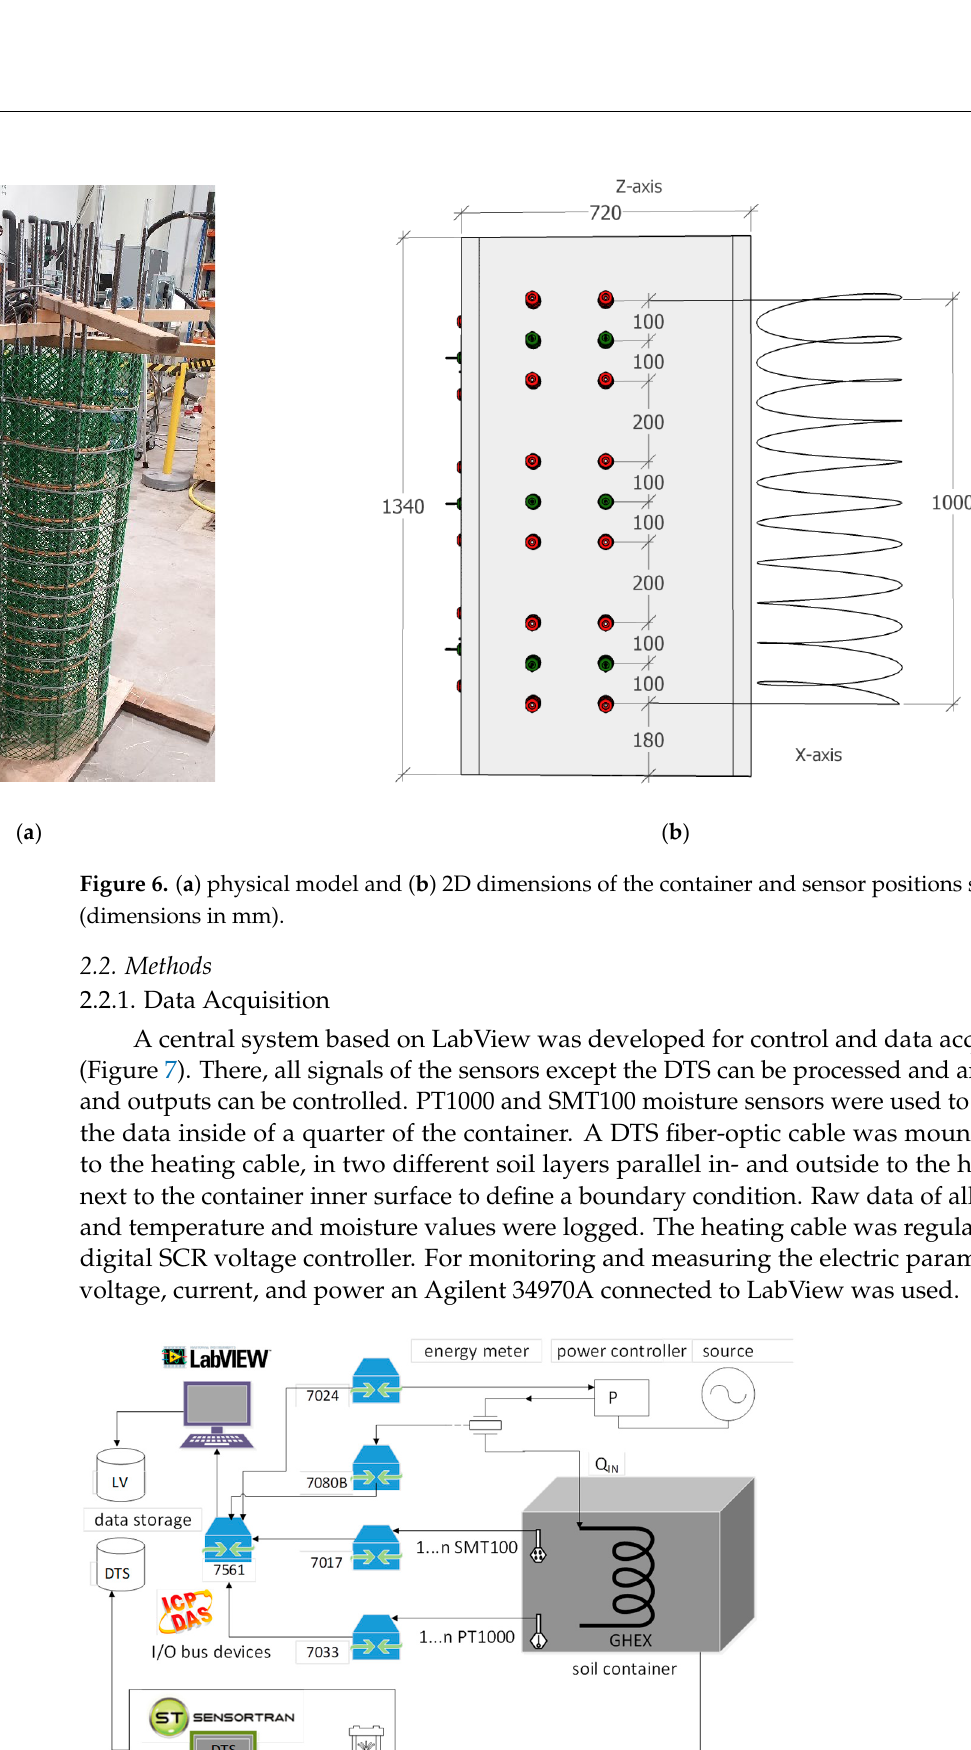
Figure 8. Coordinate system in container — isometric top view. Figure 9 shows the data points of the DTS system based on the three different diameters. “Basket” refers to the respective support grid structures where the DTS cable is installed in the same pitch level as the heating cable. The innermost basket (blue) has the smallest number of data points. The basket with the heating cable (middle basket) is shown in orange, and the outer basket, shown in green, has the largest diameter.